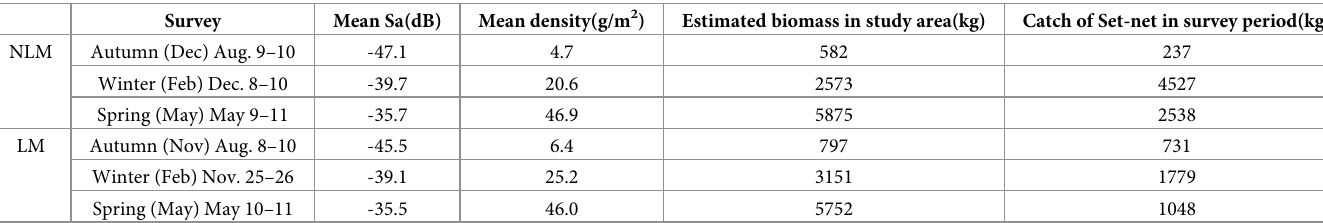
Table 2. Estimated mean surface density and fish abundance using the data of set net catches in each survey (except summer). Survey Mean Sa(dB) Mean density(g/m 2 ) Estimated biomass in study area(kg) Catch of Set-net in survey